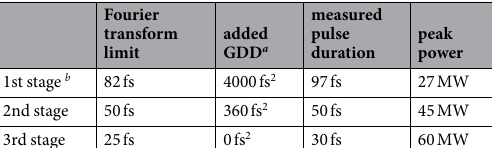
Fourier transform